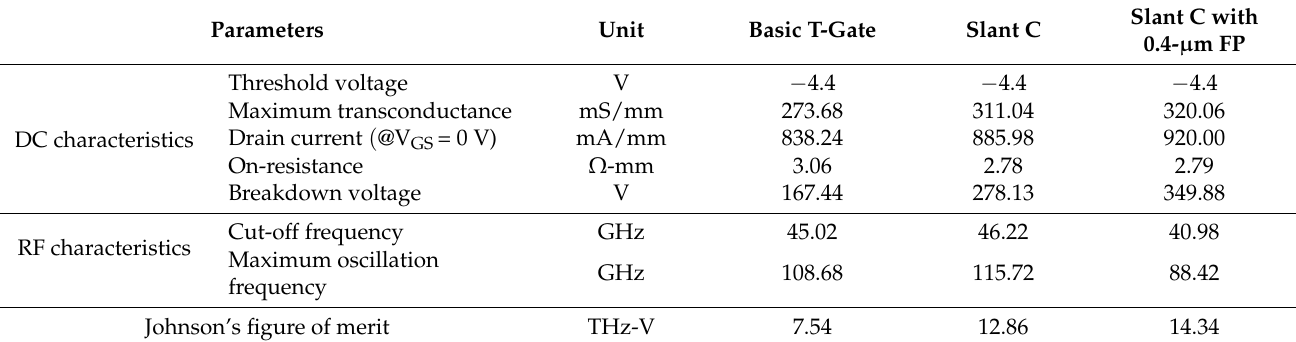
Table 4. Summary of typical DC and RF characteristics for three different gate